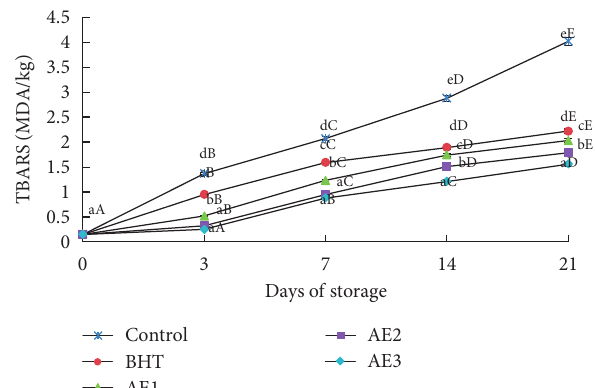
Figure 7: Effect of the aqueous pomegranate peel extract on TBARS (mg MDA/kg meat) of minced beef meat during storage at 4 ° C. 123456789